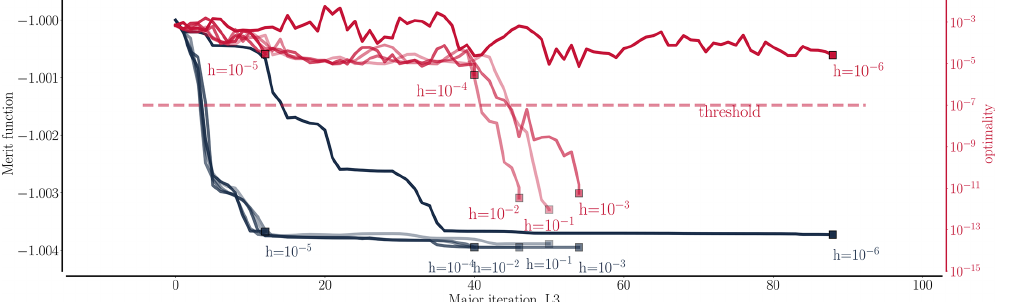
Figure 9. Merit function (black, left y axis) and optimality (red, right y axis) for shape optimizations on mesh level L3 using step sizes h = 10 − 1 , 10 − 2 , 10 − 3 , 10 − 4 , 10 − 5 , and 10 − 6 . The simulations are further described in Table 3 under the names SPL3e1c, SPL3e2c, SPL3e3c, SPL3e4c, SPL3e5c, and SPL3e6c, respectively. As seen, the three optimizations with the largest finite difference gradient step sizes converge deeply, which is not true for the three optimizations with the smallest step